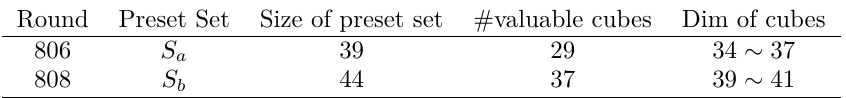
Table 2: The numbers of small valuable cubes for 806- and 808-round Trivium . Round Preset Set Size of preset set #valuable cubes Dim of cubes 806 S a 39 29 34 ∼ 37 808 S b 44 37 39 ∼